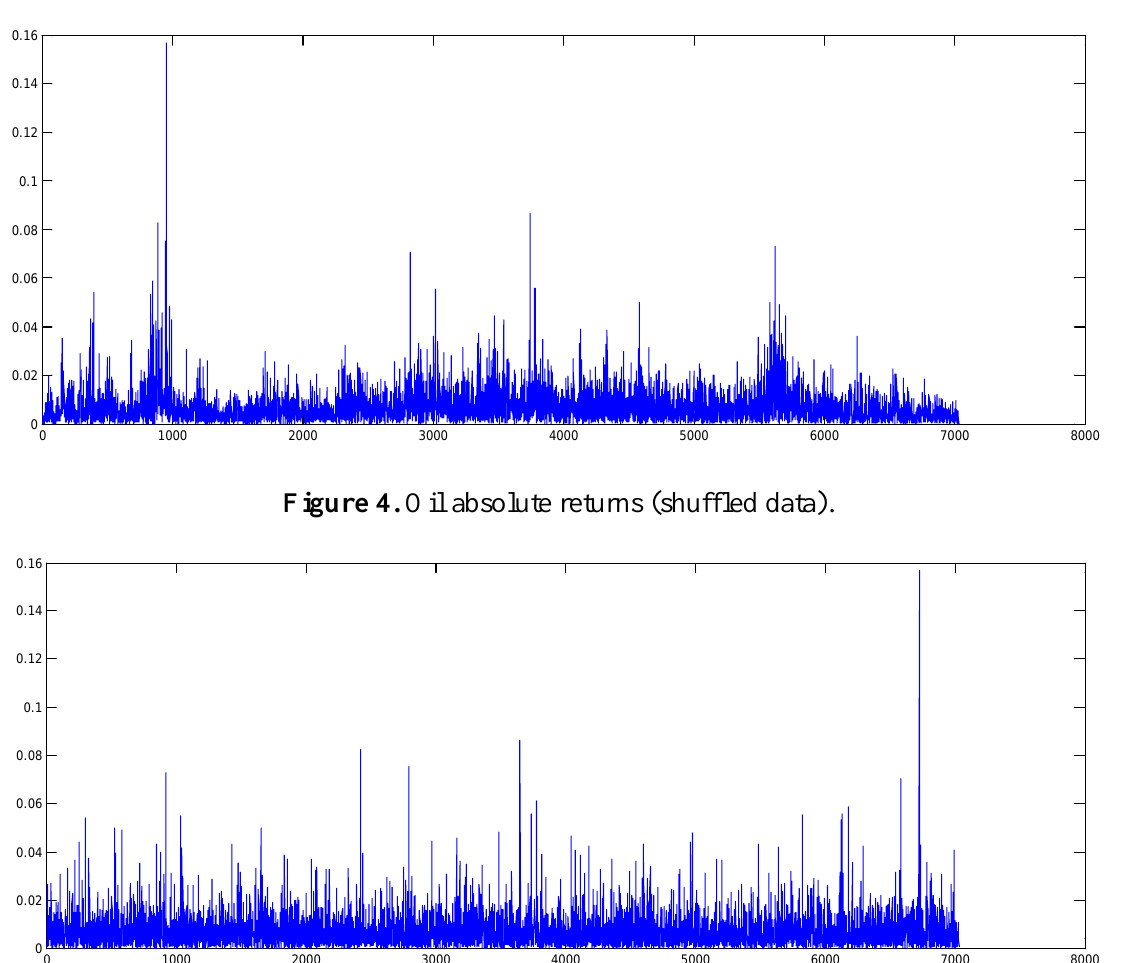
Figure 3. Oil absolute returns (original data).